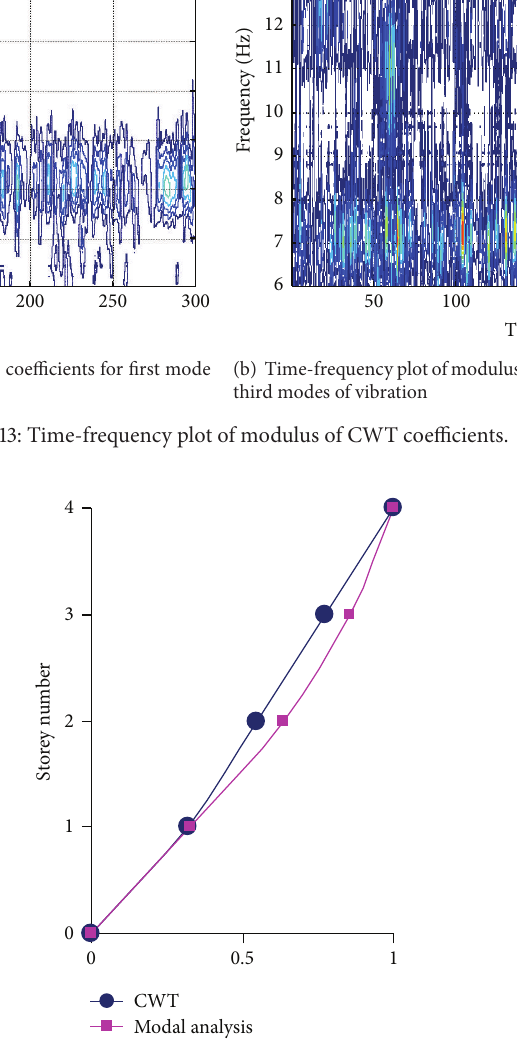
Figure 14: Comparison of mode shapes obtained from CWT and modal